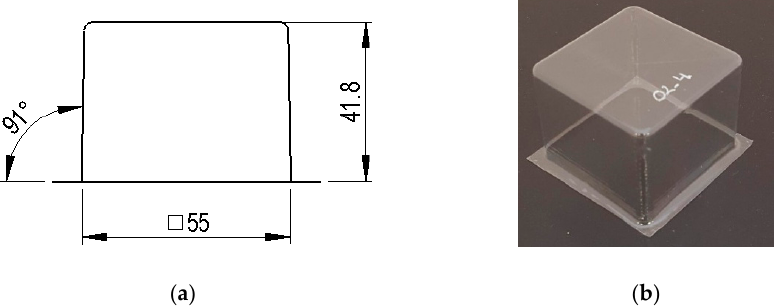
Figure 10. Images and dimensions of the plain test specimen, O2: ( a ) general dimensions; ( b ) test specimen.